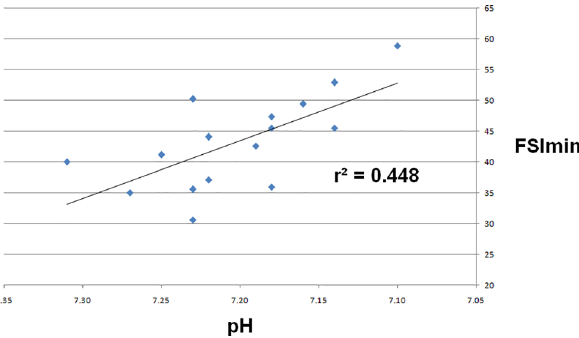
Fig 2. Correlation curve between FSI min and arterial